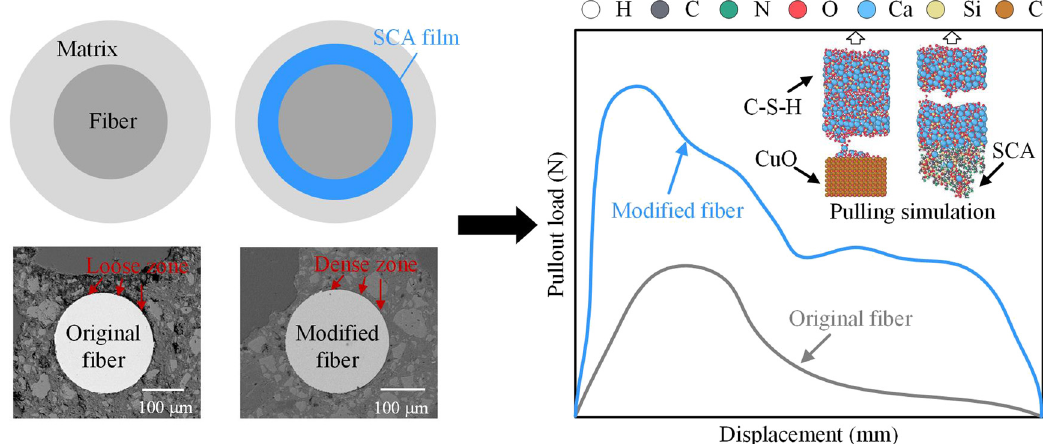
Figure 3: Morphology of original and modi fi ed fi ber embedded in SFRCC matrix. The interfacial zone between SCA modi fi ed fi ber and matrix is denser than that of original fi ber and matrix, leading to a remarkable improvement in pullout load. MD simulation demonstrates that a tight bond is formed at interface after SCA modi fi